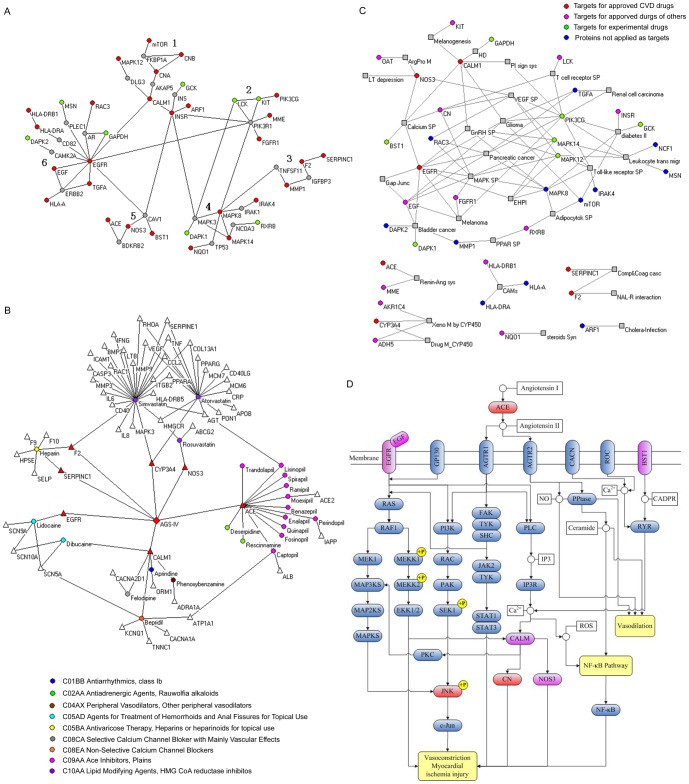
Network analysis of the efficacy of AGS-IV on myocardial injuries.(A) Constructed minimum protein-protein interaction network between targets of AGS-IV. Red and green nodes denote putative targets of AGS-IV. Red nodes have been reported in the literature as drug targets or potential targets for CVD therapy; green nodes are predicted by the INVDOCK but with no literature support. Grey nodes are proteins that link the targets together. The network was decomposed into topological compact modules, labeled with numbers, by a simulated annealing algorithm. (B) Drug-target network for cardiovascular drugs related to AGS-IV. Circles and triangles represent drugs and targets, respectively. AGS-IV and its putative direct targets are highlighted in red. Nodes for other drugs are colored according to their ATC codes at the 4th level (ATC codes are codes in the Anatomical Therapeutic Chemical (ATC) Classification System used for the classification of drugs, which is controlled by the WHO Collaborating Centre for Drug Statistics Methodology (WHOCC). Drugs are classified into groups at 5 different levels in this coding system, in which the 4th level of the code indicates the chemical/therapeutic/pharmacological subgroup). (C) Target-pathway network for putative targets of AGS-IV. Circles and squares represent targets and pathways, respectively. Target nodes are colored according to Drugbank drug classes. Known targets of approved CVD drugs are highlighted in red. (D) Pathway associated with myocardial ischemia injury. This pathway was constructed by integrating pathways reported to be involved in the process of myocardial ischemia injury, including the calcium signaling, MAPK, JAK-STAT and NF-KB pathway. Red and pink boxes indicate putative target proteins of AGS-IV; targets in red were experimentally validated in this study.